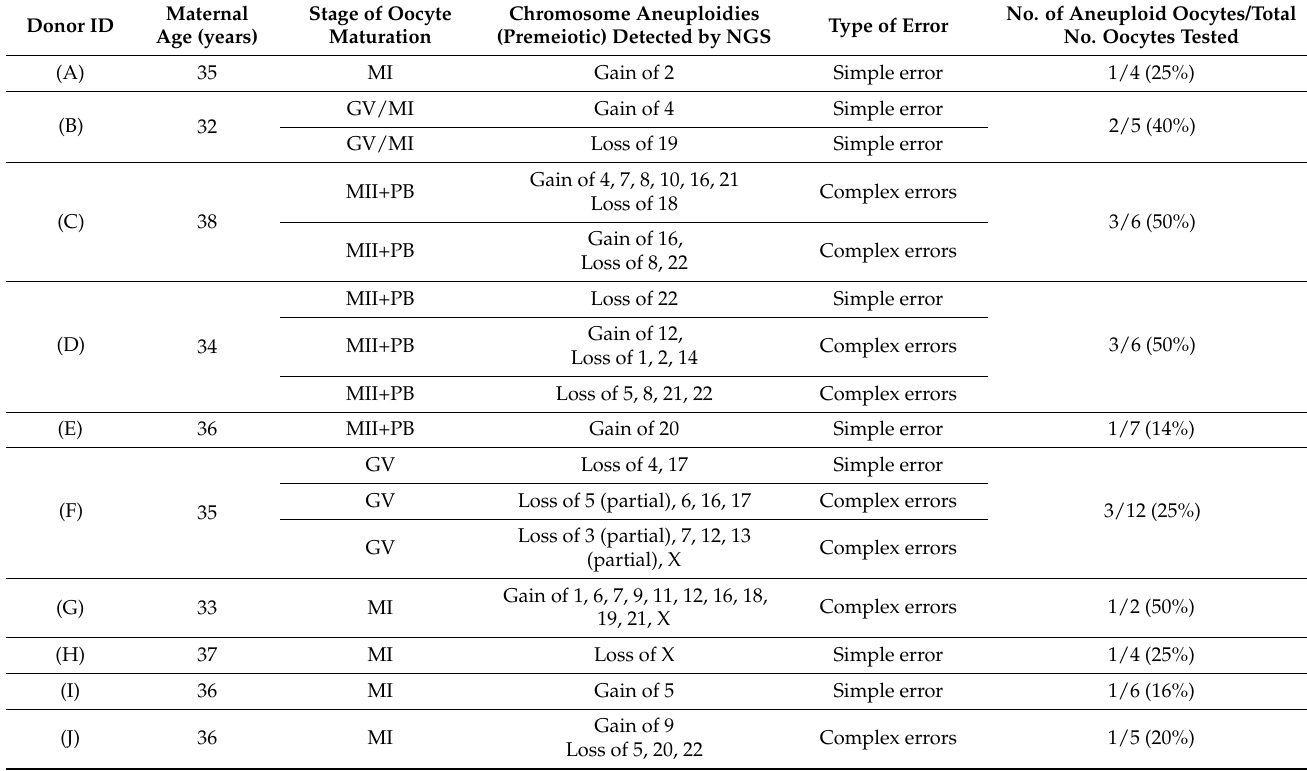
Table 2. Detailed NGS results of aneuploid GV, MI and MII+PB complexes showing premeiotic